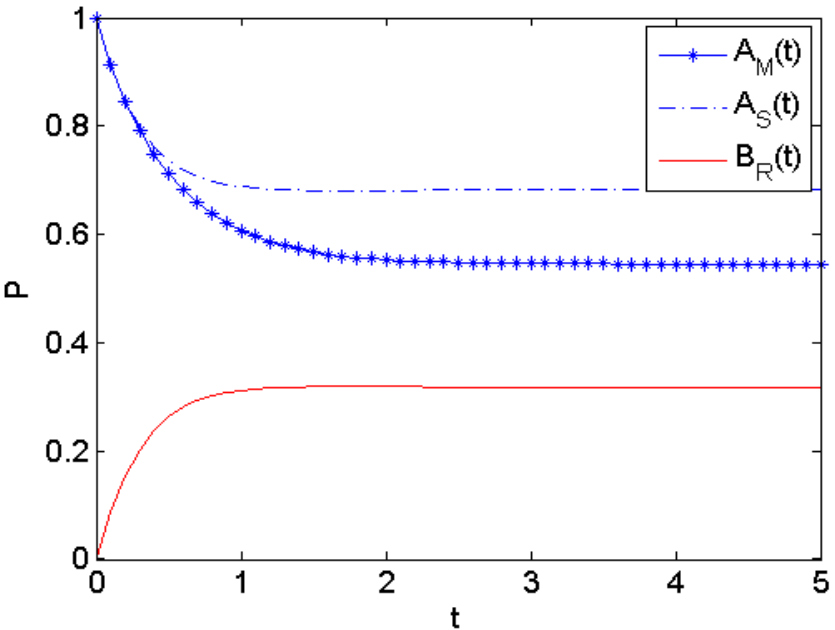
Figure 3. The transient-state indices of the system for λ = 1, µ = 2, ξ 1 = 1, ξ 2 = 1.5, η 1 = 2 and η 2 = 3.